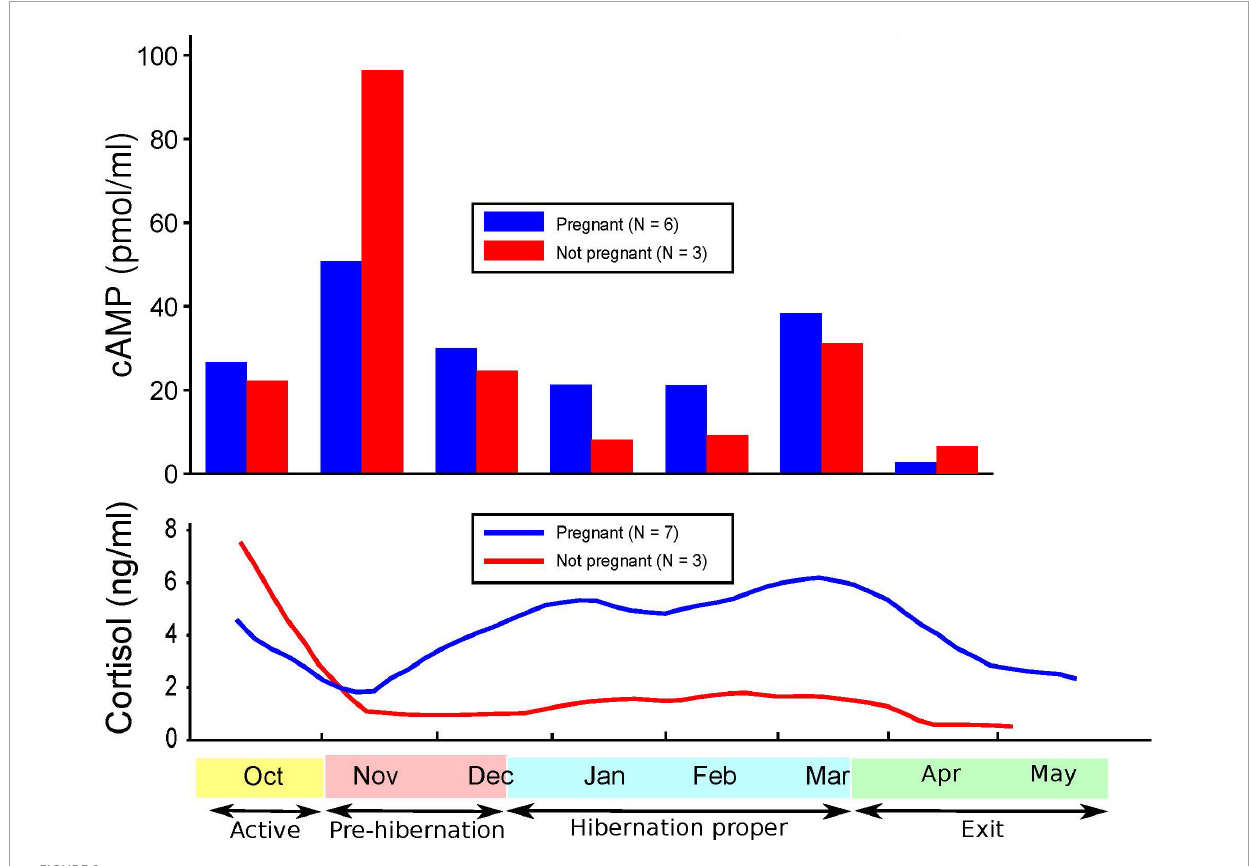
FIGURE2 Levels of cyclic adenosine monophosphate (cAMP) and cortisol over time and pregnancy status.